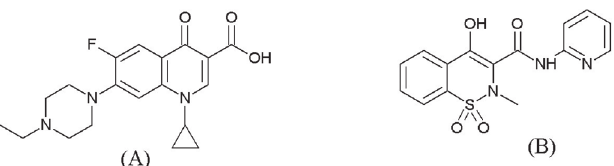
FIGURE 1 - Chemical structures of enrofloxacin (A) and piroxicam